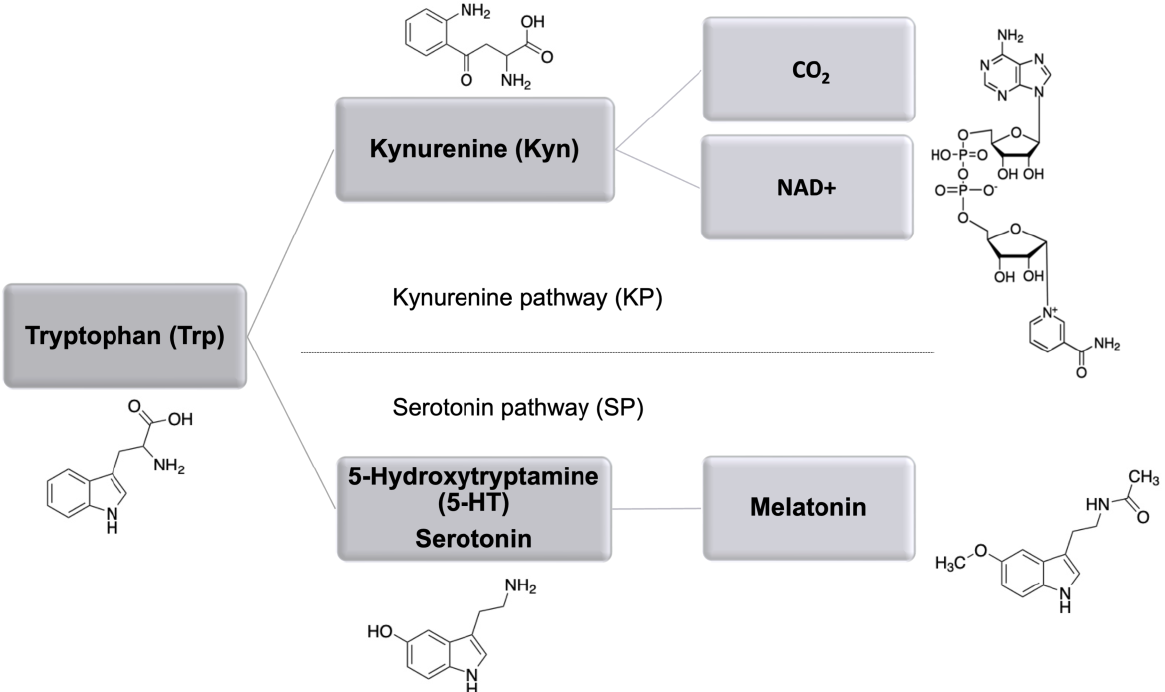
Figure 1. Schematic presentation of the main Trp catabolic routes including kynurenine (KP) and serotonin (SP) pathway with the key metabolites.